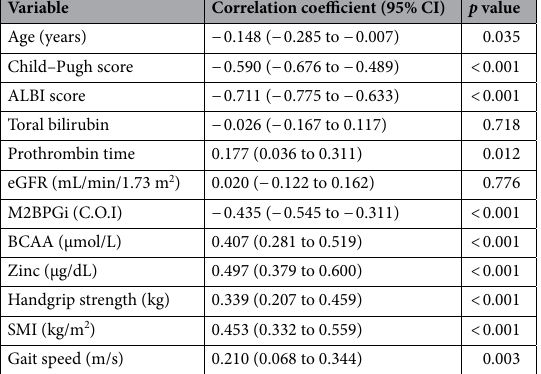
Table 2. Correlations between the GNRI values and baseline characteristics. ALBI albumin-bilirubin, BCAA branched-chain amino acid, CI confidence interval, eGFR estimated glomerular filtration rate, M2BPGi Mac-2 binding protein glycosylation isomer, SMI skeletal muscle mass index.